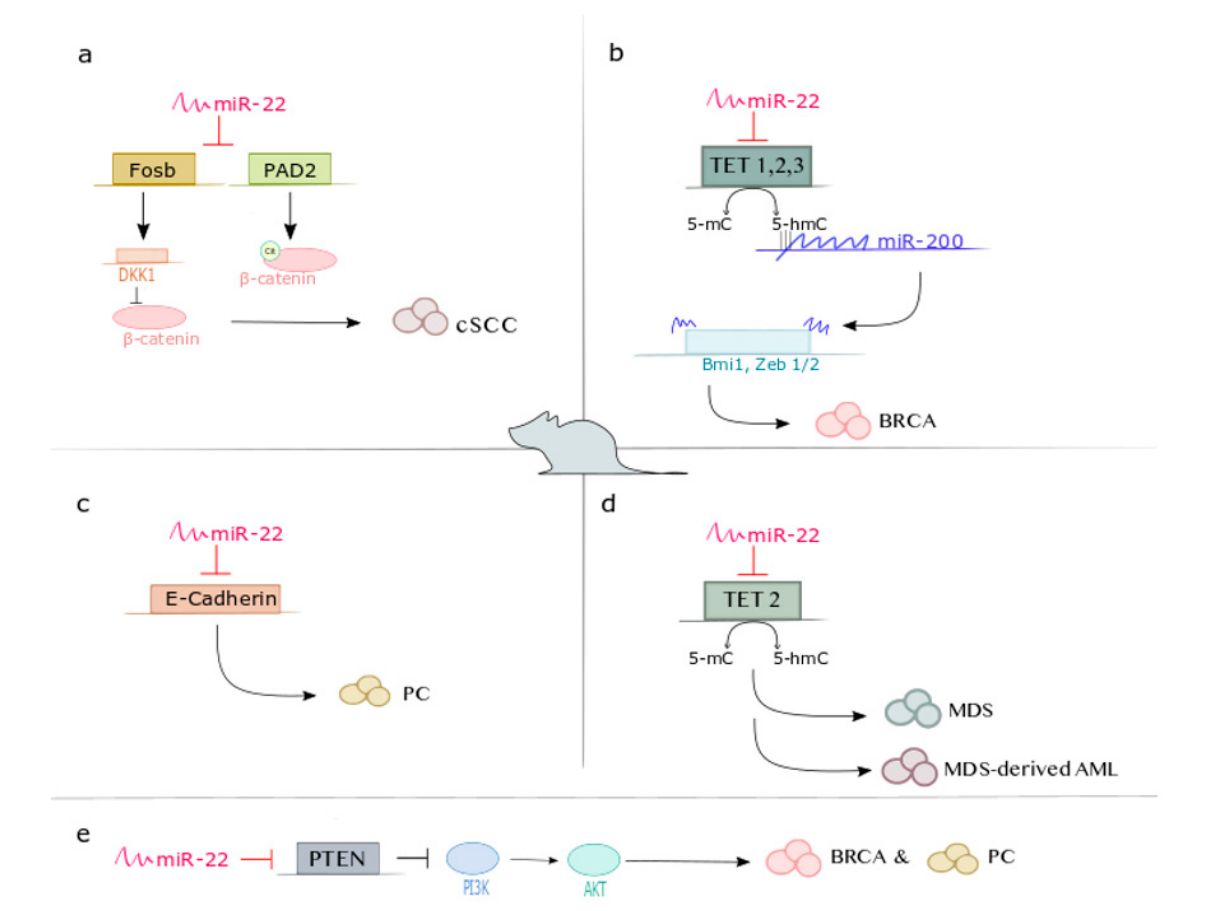
Figure 2. Mir-22 oncogenic role in cancer. Scheme of miR-22 functional mechanisms in promoting tumorigenesis of cutaneous squamous cell carcinoma (cSCC), breast cancer (BRCA), prostate cancer (PC), and Leukemia in immunocompetent ( a – d ) and xenograft ( e ) mouse models. ( a ) miR-22 promotes cSCC initiation and progression, repressing Wnt/ β -catenin signaling by targeting Fosb and PAD2. ( b ) Epigenetic inactivation of miR-200 through miR-22 targeting the TET family in breast cancer triggers EMT and increases mammary tumorigenesis and metastasis. ( c ) miR-22 promotes tumor invasion in prostate cancer targeting E-Cadherin. ( d ) miR-22 decreases the level of 5-hmC by negatively regulating TET2 leading to MDS and MDS-derived leukemia. ( e ) Increased levels of miR- 22 directly target PTEN, which results in PI3K/AKT signaling pathway upregulation and cancer progression in Breast and Prostate in vivo mouse models.